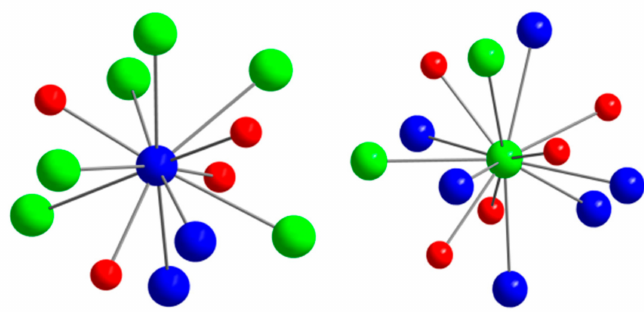
Figure 4. The crystal structure of grammatikopoulosite projected down [10]. Blue, green, and red circles refer to M 1, M 2, and P, respectively.